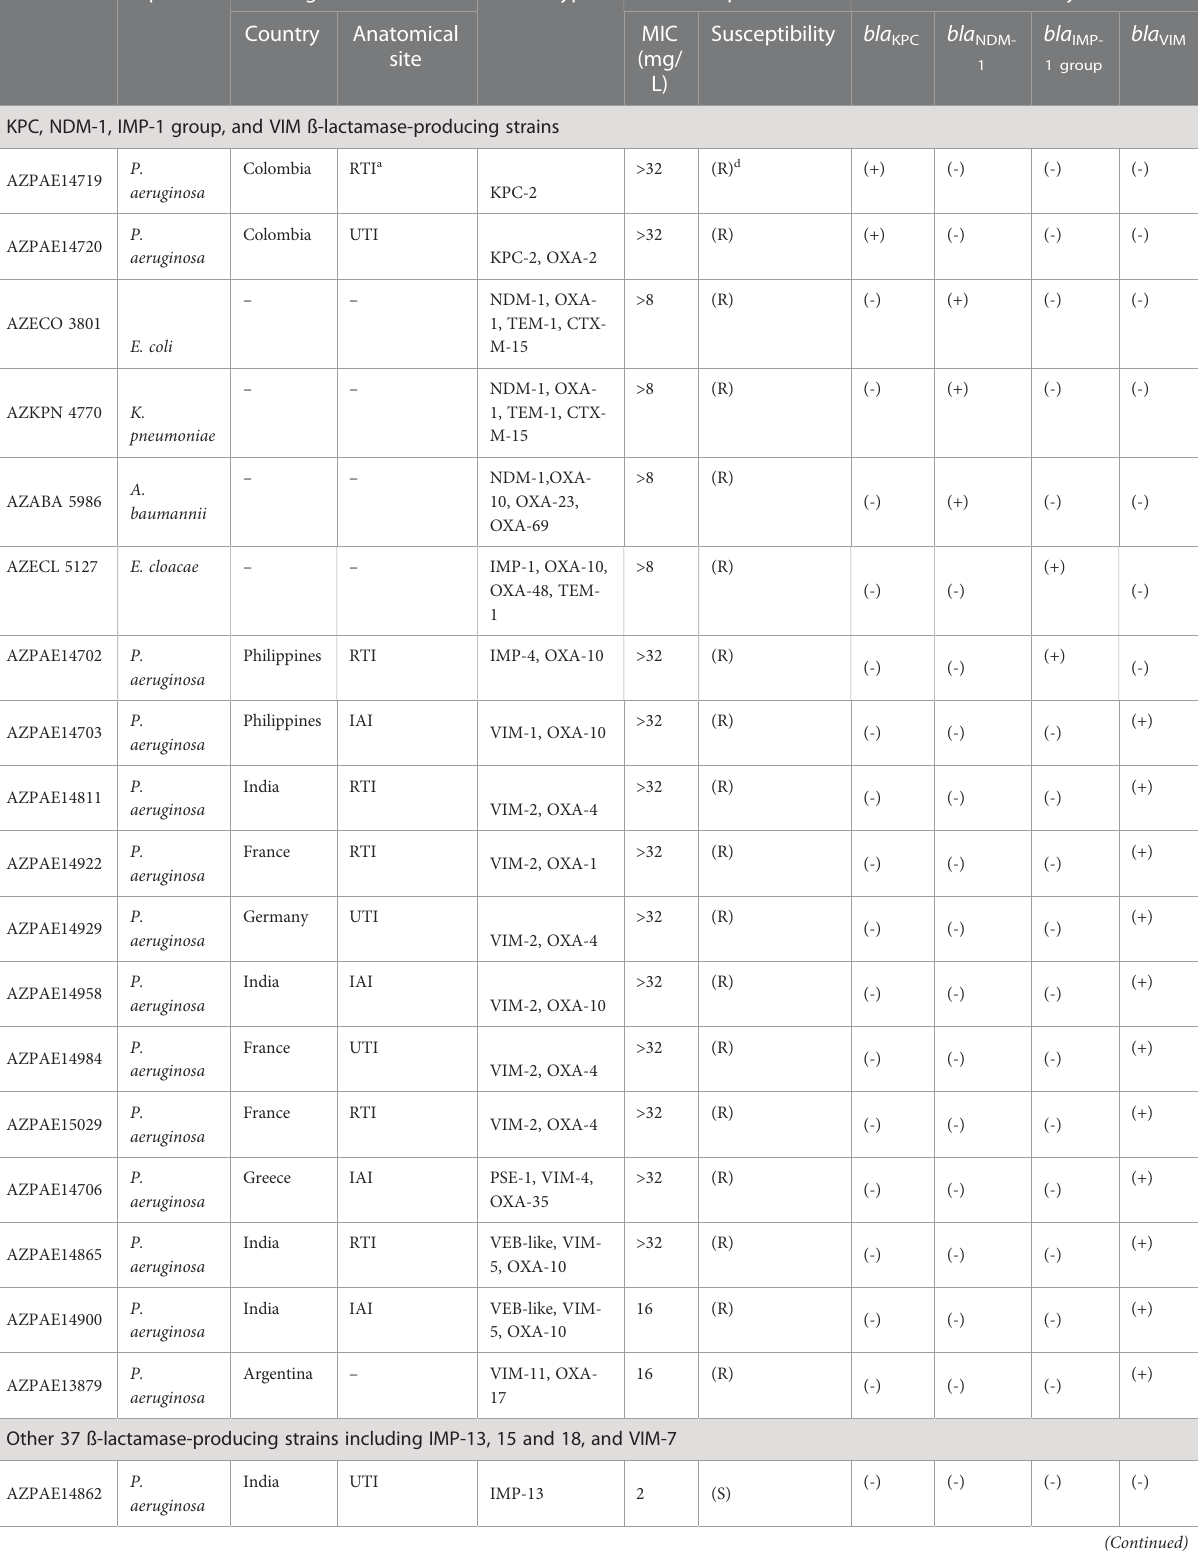
TABLE 2 Clinical isolates